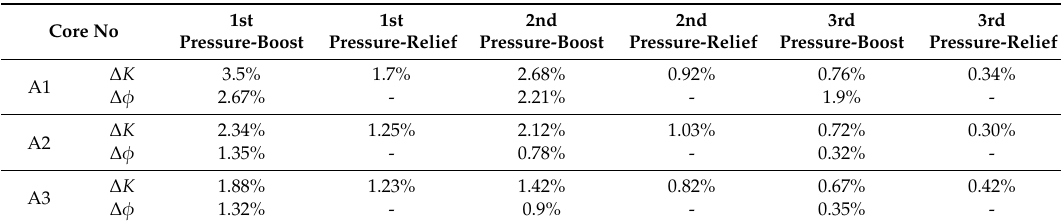
Table 3. The rate of core permeability and porosity under the operating pressure of underground gas storage